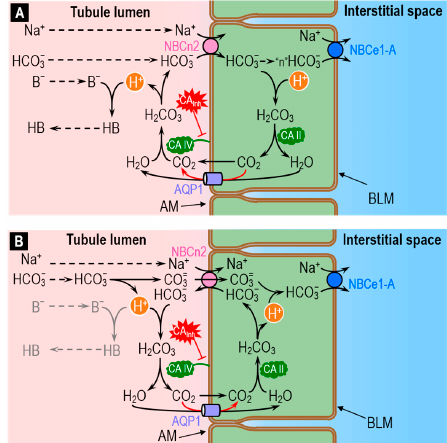
Figure 8. Two models of how the electroneutral Na / HCO 3 cotransporter NBCn2 could mediate the reabsorption of HCO 3 − and titration of non-CO 2 / HCO 3 − bu ff ers in the renal proximal tubule (PT). Guo et al. discovered that a variant of NBCn2 (first 4 N-terminal amino acids: MCDL) is present at the apical membrane of proximal-tubule (PT) cells [90]. Although NBCn2 is generally depicted as mediating NaHCO 3 uptake ( A ), evidence suggests that it in fact is an exchanger. If so, the simplest model is that it exchanges Na + plus CO 3 = for HCO 3 − ( B ). ( A ) NBCn2 as a cotransporter. If the apical NBCn2 directly moves the filtered Na + and HCO 3 − into the cytosol, the result would be a deficit of Na + and HCO 3 − in the nanodomains near the transporter. One means of replenishing the lost NaHCO 3 would be the di ff usion of Na + and HCO 3 − from the bulk luminal fluid to the apical membrane. Another means of replenishing the HCO 3 − would be the conversion of CO 2 and H 2 O to HCO 3 − and H + , facilitated by apical CA IV. Our simulations [90] suggest that the reaction (H 2 O + CO 2 → H + + HCO 3 − ) accounts for only a small fraction of total HCO 3 − replenishment. The newly produced HCO 3 − would move into the cytosol via NBCn2, whereas the newly produced H + would either titrate B − to form HB, or remain unbu ff ered. In the cytosol, most of the HCO 3 − arriving via NBCn2 would di ff use toward the basolateral membrane, for exit via the electrogenic Na / HCO 3 cotransporter NBCe1-A. However, a small fraction of the entering HCO 3 − would in principle, under the catalytic action of CA II, recycle back into the lumen—mostly via aquaporin 1 (AQP1)—as H 2 O and CO 2 . This di ff usion of H 2 O and CO 2 is in the direction opposite shown in Figure 7, but would ultimately be responsible for the titration of B − to HB. In a real PT, the H 2 O and CO 2 necessary to replenish luminal HCO 3 − could come from Na-H exchange and H + pumping, as shown in Figure 7. ( B ) NBCn2 as an exchanger. In this model, filtered Na + and HCO 3 − di ff uses from the bulk luminal fluid towards NBCn2. The HCO 3 − that approaches NBCn2 dissociates into CO 3 = and H + , with CO 3 = entering the PT cytosol via NBCn2. Virtually all of the newly produced luminal H + titrates the HCO 3 − that NBCn2 moves out of the PT cell. The result is the formation of luminal H 2 O and CO 2 —catalyzed by apical CA IV—and the subsequent influx of H 2 O and CO 2 , again mostly via AQP1, into the cytosol. Once inside the cell, the CO 2 and H 2 O—catalyzed by CA II—would regenerate HCO 3 − for export into the lumen via NBCn2, and H + , which would titrate the incoming CO 3 = to HCO 3 − , which would eventually exit the cell via NBCe1-A. Note that, in this scenario, virtually no luminal H + would be left over to titrate B − to HB. In other words, NBCn2 would appear to mediate the pure uptake of NaHCO 3 without titrating other bu ff ers. AM, apical membrane; BLM, basolateral membrane; CA Inh , carbonic anhydrase